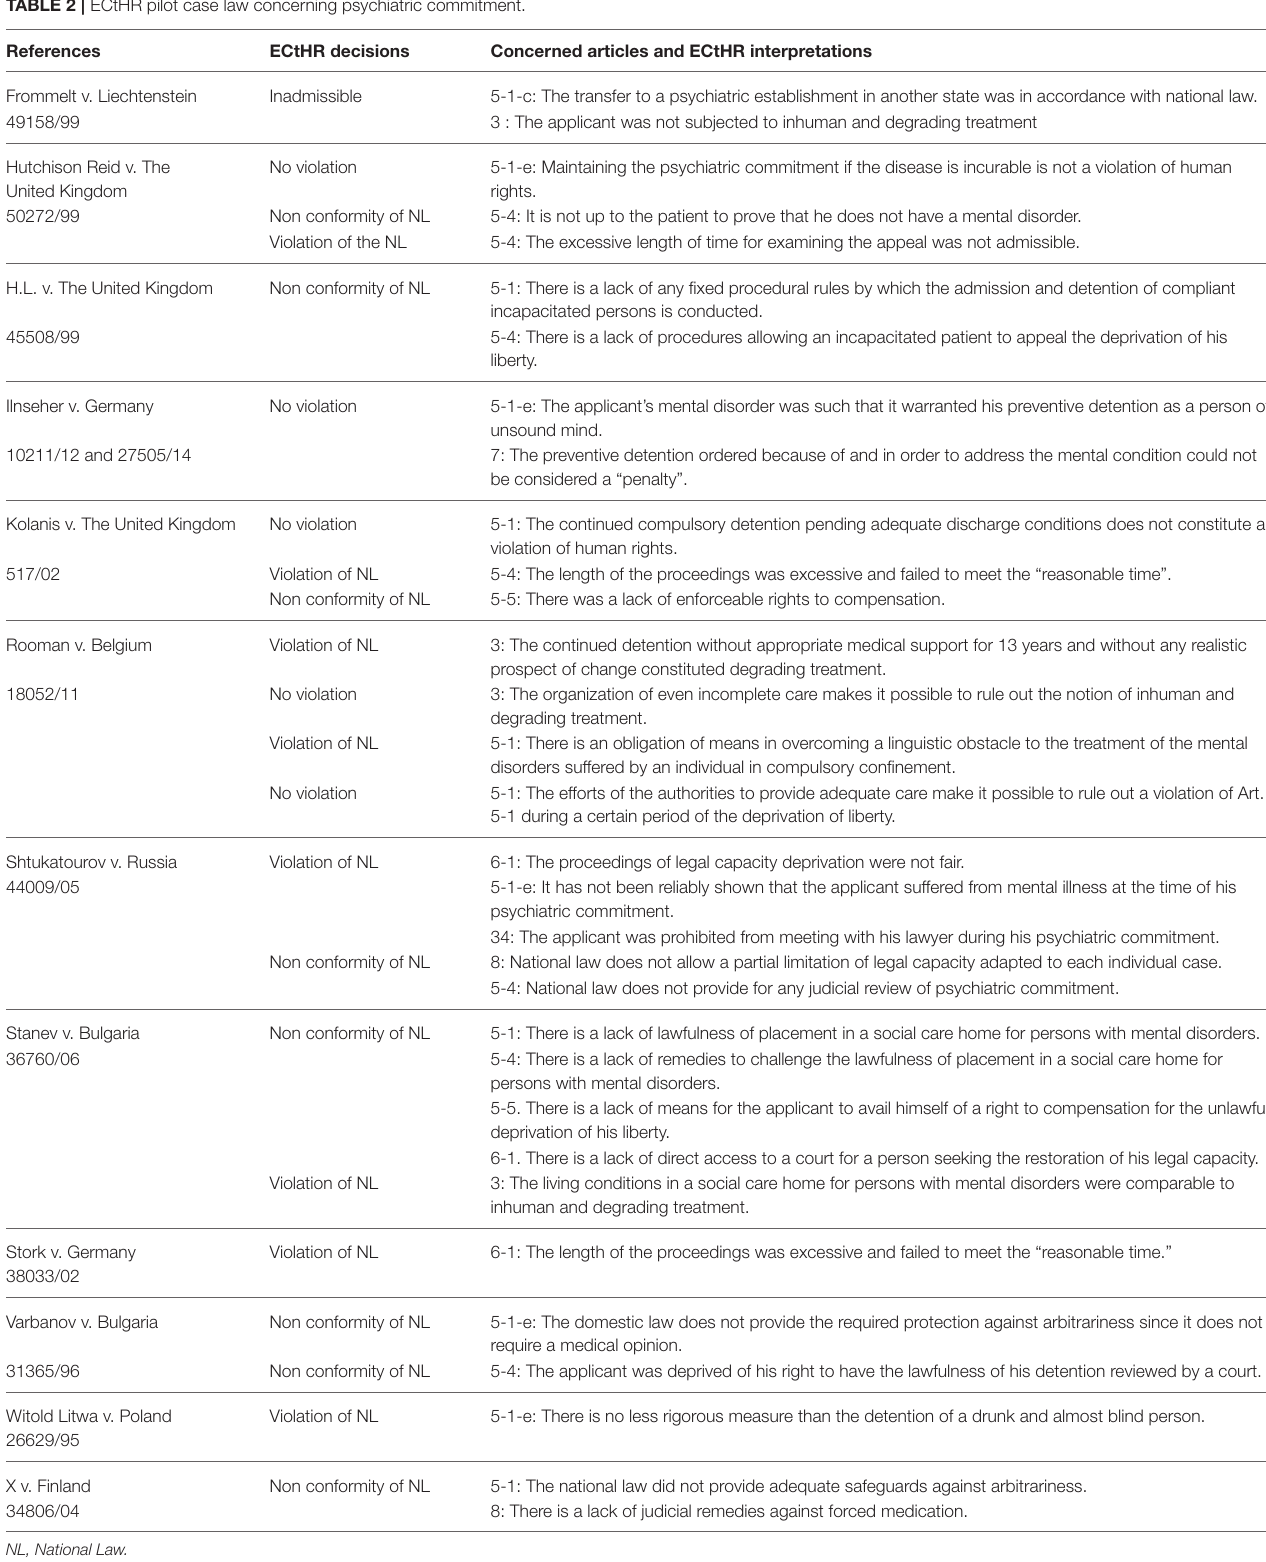
TABLE 2 | ECtHR pilot case law concerning psychiatric